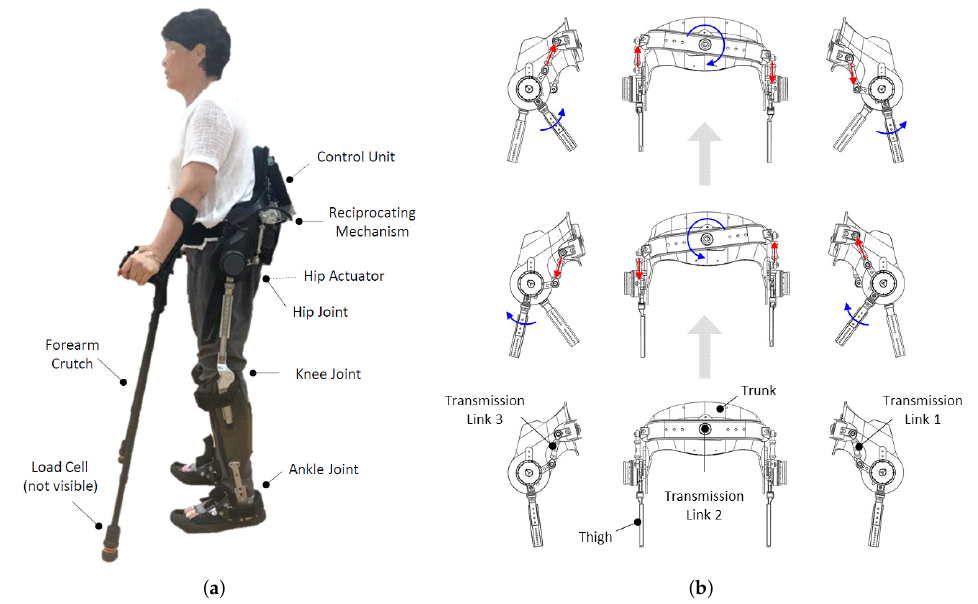
Figure 1. Reciprocating gait orthosis ( a ) and its reciprocating mechanism ( b ). Hip actuators were attached under the POWERED condition; they were not attached under the RGO